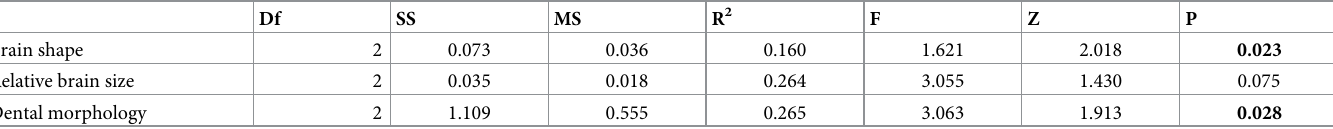
Table 3. Procrustes ANOVAs testing for differences in allometry- and phylogeny-corrected brain size and shape and dental morphology across dietary guilds.